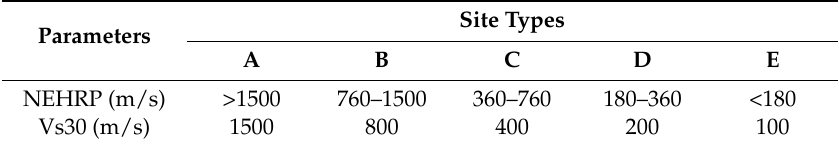
Table 3. Parameters of the Pacific Earthquake Engineering Center (PEER) NGA 2 spectra model under Table 4. Details of the selected PEER ground motion records. different site conditions.